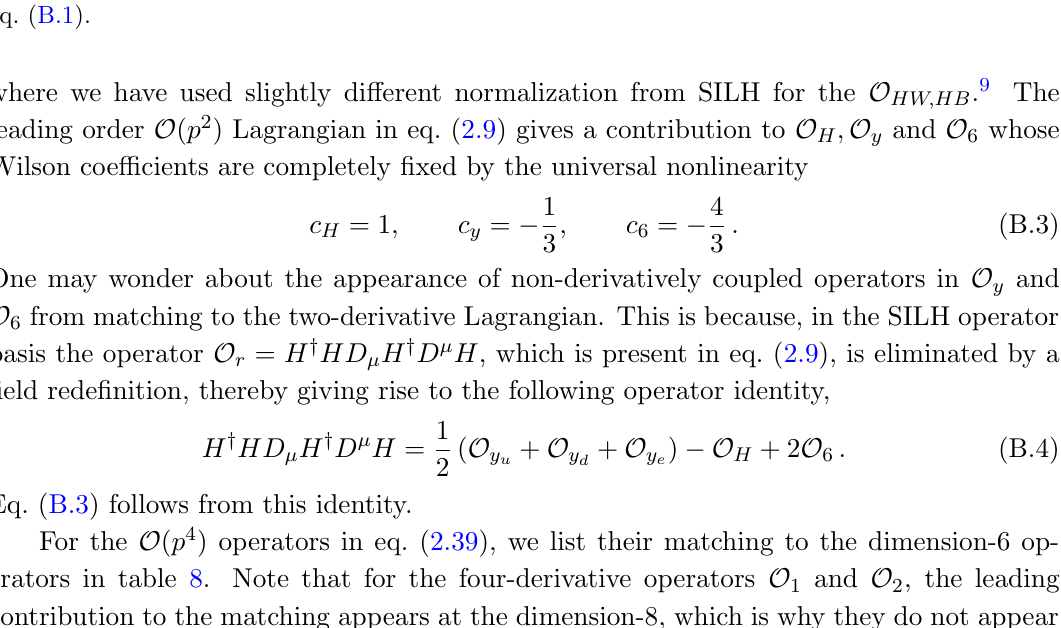
( p 4 ) opeartors in eq. (2.39) to the dimension-6 operators de(cid:12)ned in O